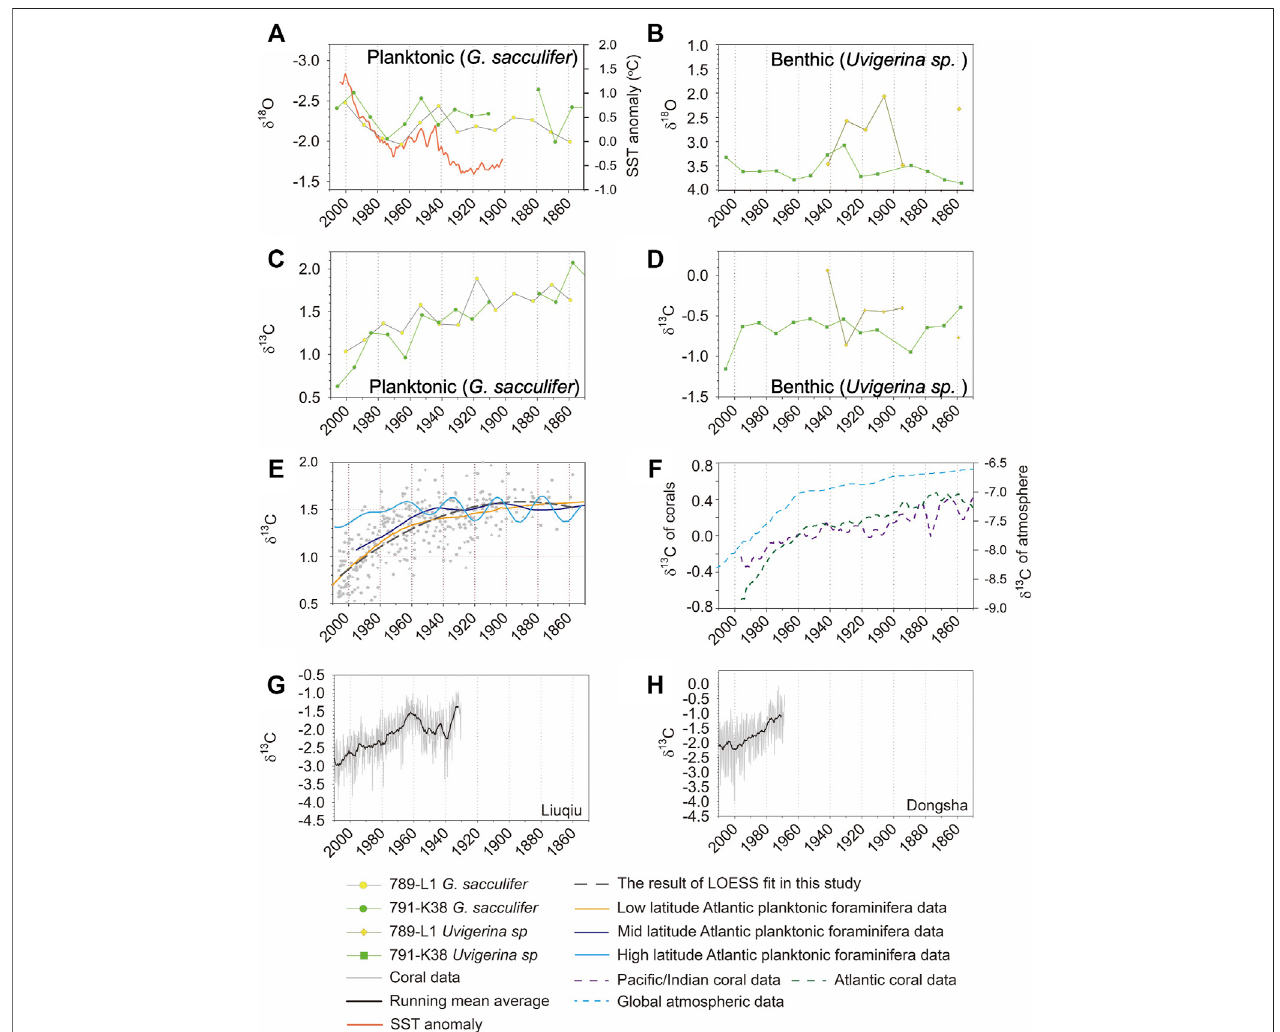
FIGURE 4 | (A) The δ 18 O of G. sacculifer in core 789-L1 and 791-K38 combine with the anomaly of sea surface temperature around Taiwan (adopted from Shiu et al., 2009). (B) The δ 18 O of Uvigerina sp. in core 789-L1 and 791-K38. (C) The δ 13 C of G. sacculifer in core 789-L1 and 791-K38. (D) The δ 13 C of Uvigerina sp. in core 789-L1and791-K38. (E) Thelightgraysymbolshowsallthe δ 13 Cofplanktonicforaminifersinthisstudy,andtheLOESS fi trepresentthesituationinthemid-lowlatitude Paci fi c Ocean. The orange, purple, and light blue lines represent the situation of planktonic foraminifera in the Atlantic Ocean at low, mid, and high latitudes, respectively (adopted from Black et al., 2011; Mellonet al., 2019; Simon et al., 2020).The δ 13 C axis ofthesethree data sets wasshifted tofacilitatecomparison withour data. (F) The δ 13 C of corals in the Atlantic and the Paci fi c/Indian Oceans (green and purple lines; adopted from Swart et al., 2010), and the global δ 13 C of atmosphere (light blue line; Graven et al., 2017). (G) The δ 13 C of coral record from Liuqiu. (H) The δ 13 C of coral record from Dongsha. The gray line represents the raw data, and the black line is the 4-year running mean